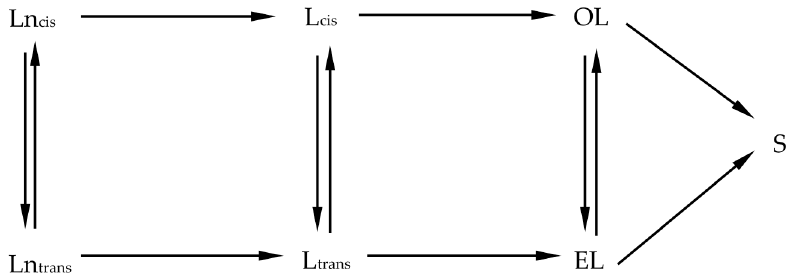
Scheme 4. Reaction paths for the hydrogenation of soybean oil by Jovanovi´c et al. [24].